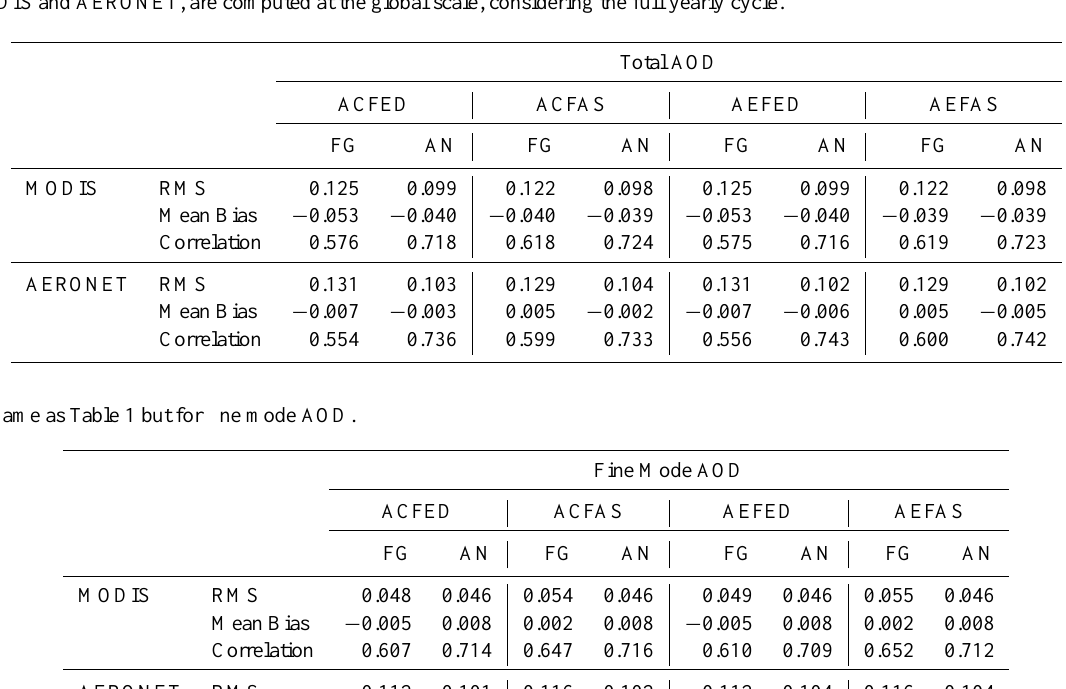
Table 1. Statistics quantifying the difference in total AOD between the first guess (FG) or analysis (AN) and MODIS or AERONET for all four experiments ACFED, ACFAS, AEFED and AEFAS. For each AERONET station, the closest model grid box is used. The statistics for both, MODIS and AERONET, are computed at the global scale, considering the full yearly cycle.